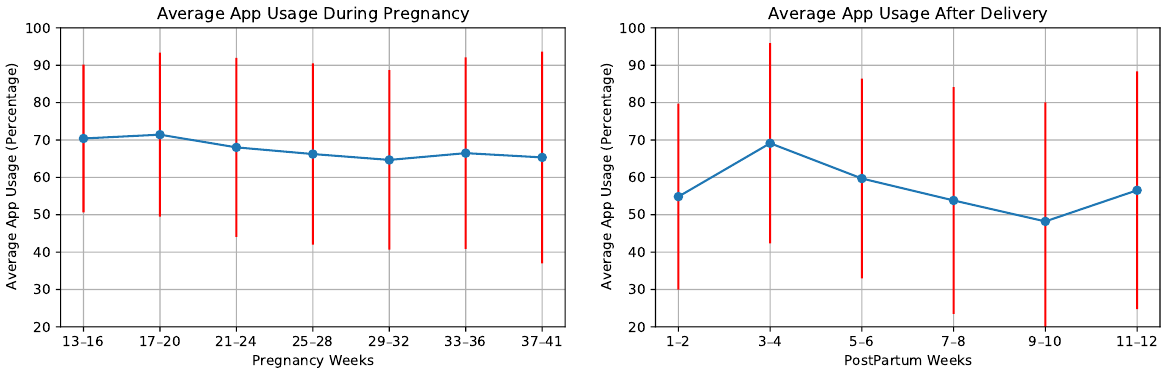
Figure 7. Average mobile application usage (participants engagement in answering daily questions) during pregnancy and postpartum of the 28 high-risk pregnant women.